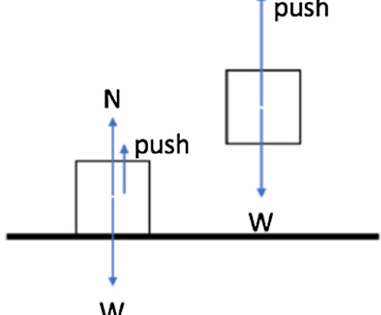
FIG. 8. Our interpretation of student reasoning that it takes more force to keep the box moving, since you no longer have “ assistance f[ro]m the ground. ”